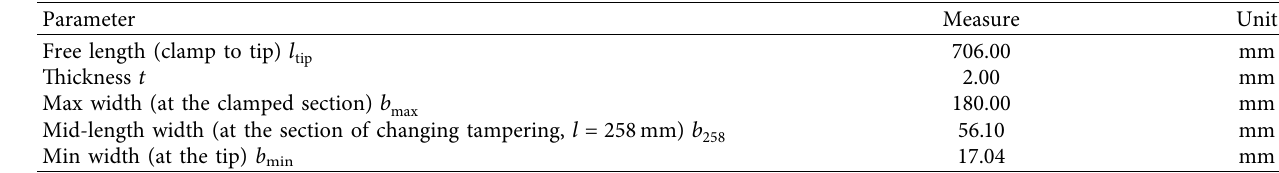
Table 2: The geometry of the wing spar.